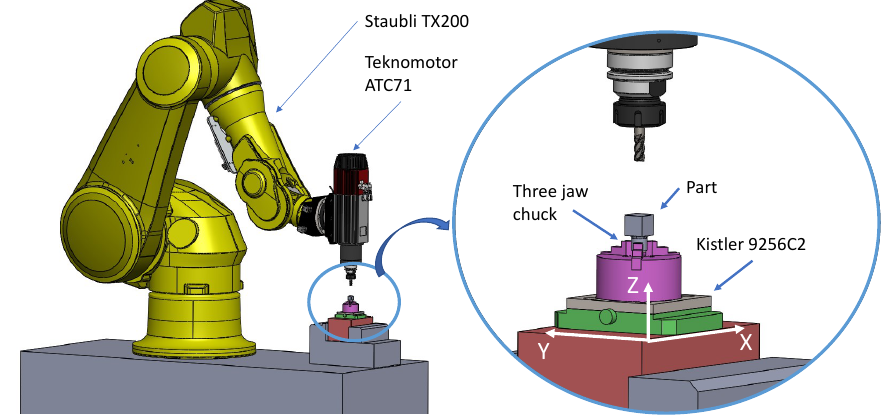
Figure 4. Cutting